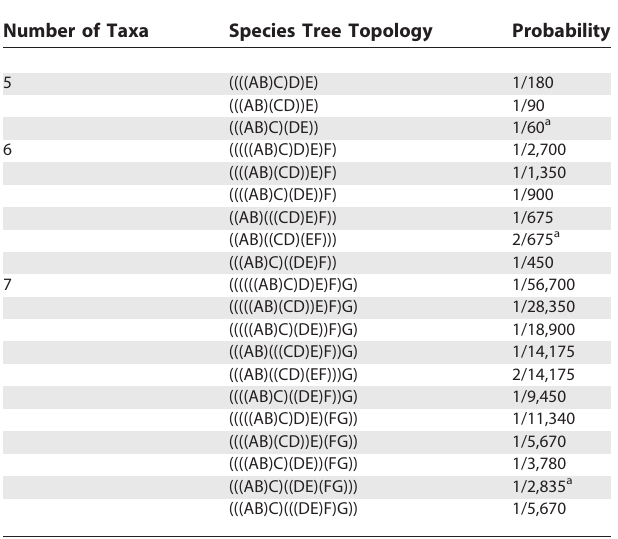
Table 1. n -Maximally Probable Topologies for n ¼ 5, 6, 7 Number of